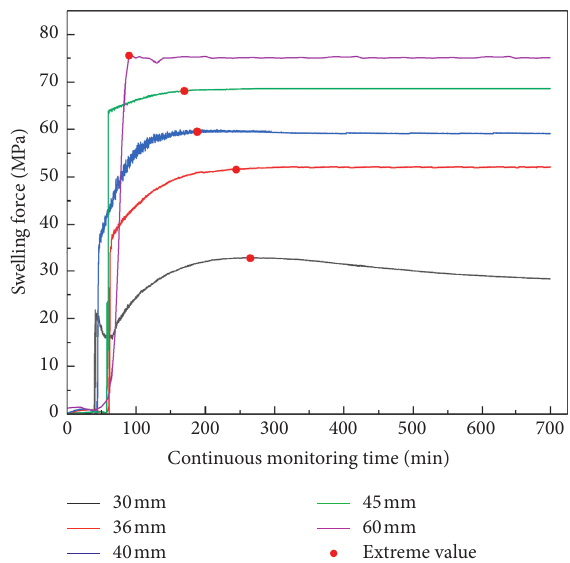
Figure 8: Swelling characteristics of five hole